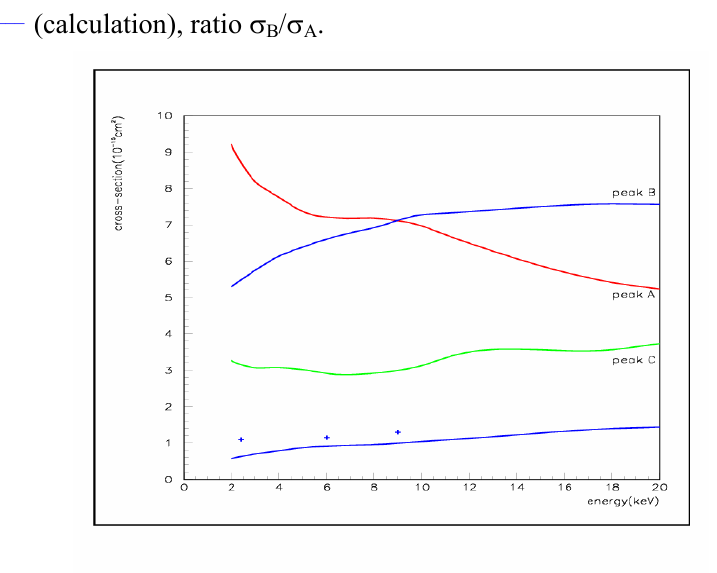
Figure 8: Partial cross sections on the S 3+ (3s 2 3p) 2 P + He levels with respect